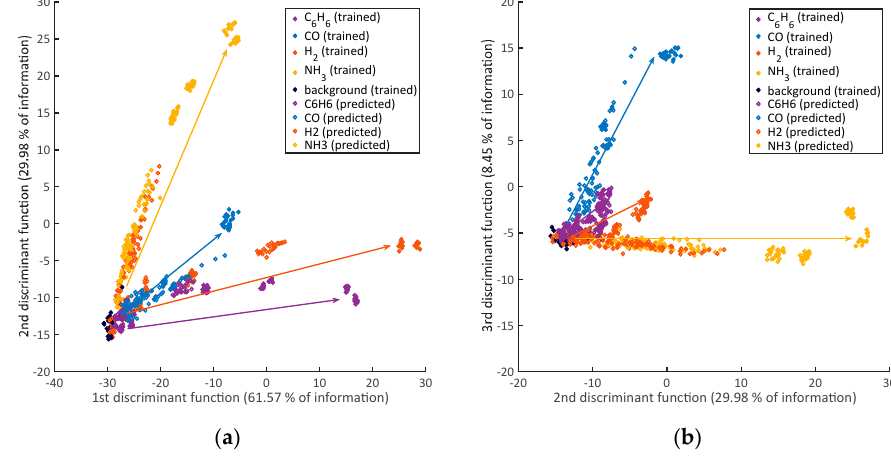
Figure 5. A 3D-LDA (Linear Discriminant Analysis) scatterplot trained (filled circles) by background air and the highest concentration from the (cid:1863) (cid:3560) -evaluation of each gas, all other lower concentrations are predicted (empty circles), each gas has its own direction to step out of the background air data. The (cid:1863)(cid:3560) for the three different low temperatures have been used as features; ( a ) shows the first two discriminant functions; ( b ) the second and third.